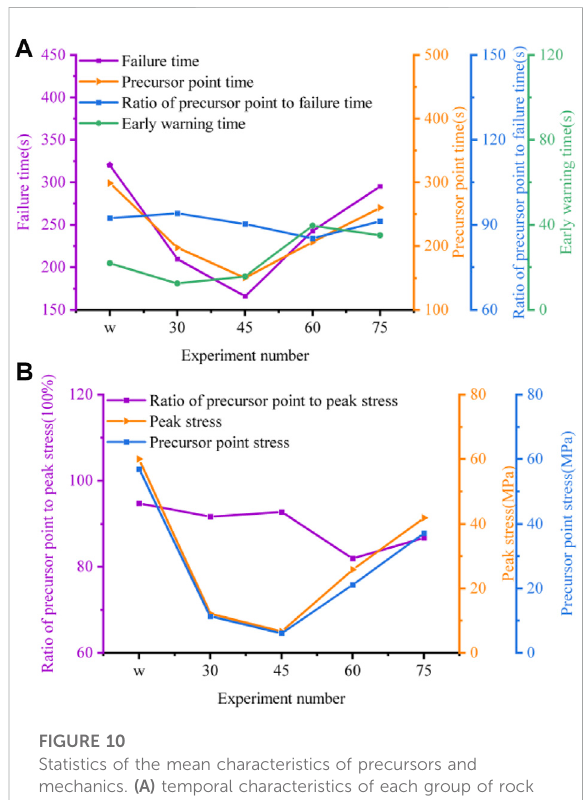
FIGURE 10 Statistics of the mean characteristics of precursors and mechanics. (A) temporal characteristics of each group of rock samples and (B) mechanical characteristics of each group of rock